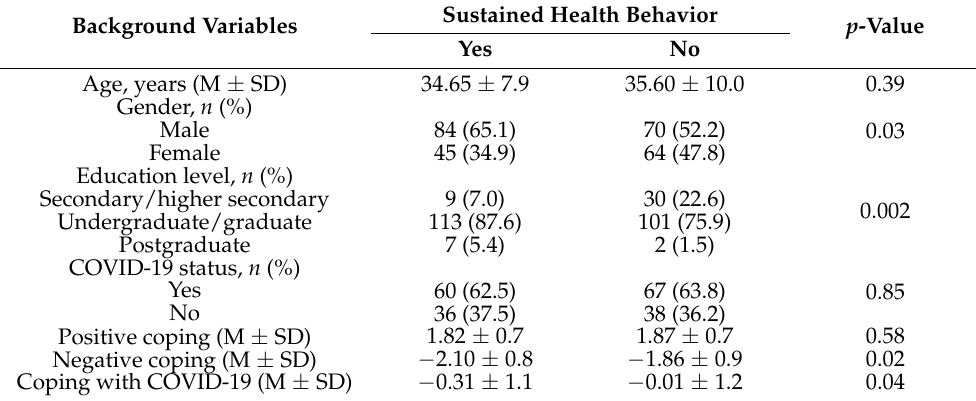
Table 4. Characteristics and coping with COVID-19 in terms of sustained health behavior among working-age people aged 19–65 years ( n =